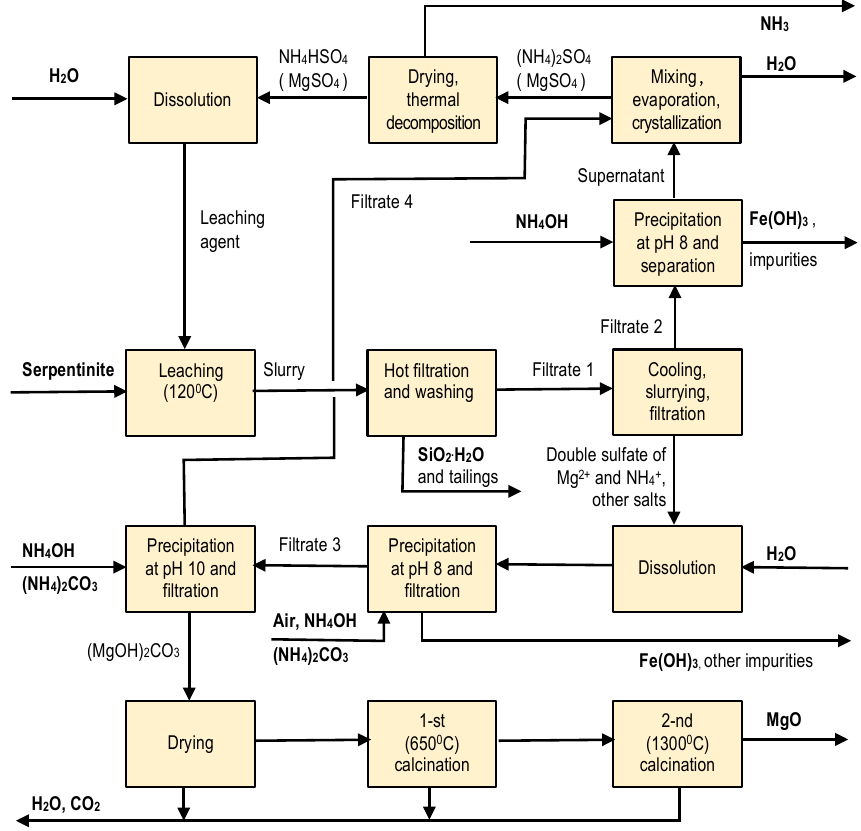
Figure 1. Flow chart for obtaining MgO from serpentinite. Table 1. Chemical composition of serpentinite.